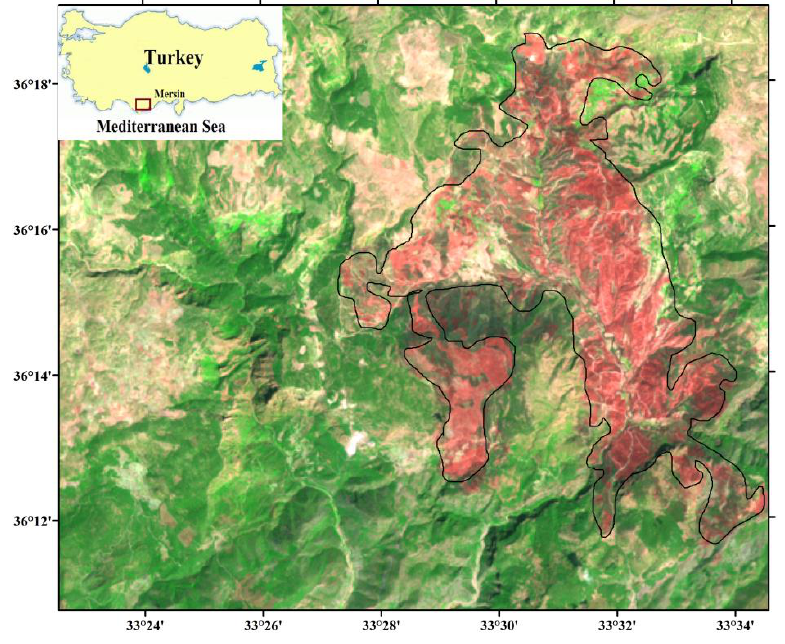
Figure 1. Location of study